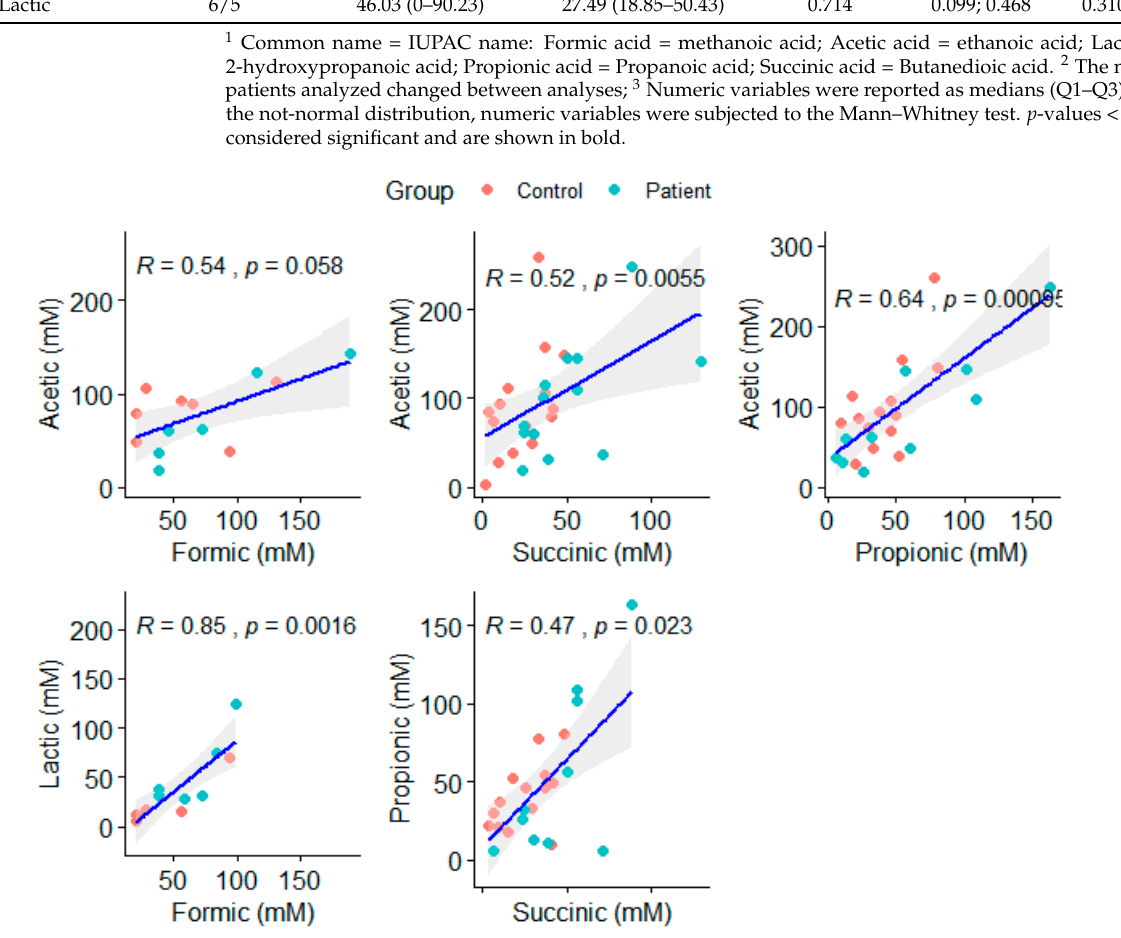
Figure 1. Significative correlations ( p > 0.05) between acetic, propionic, succinic, lactic and formic